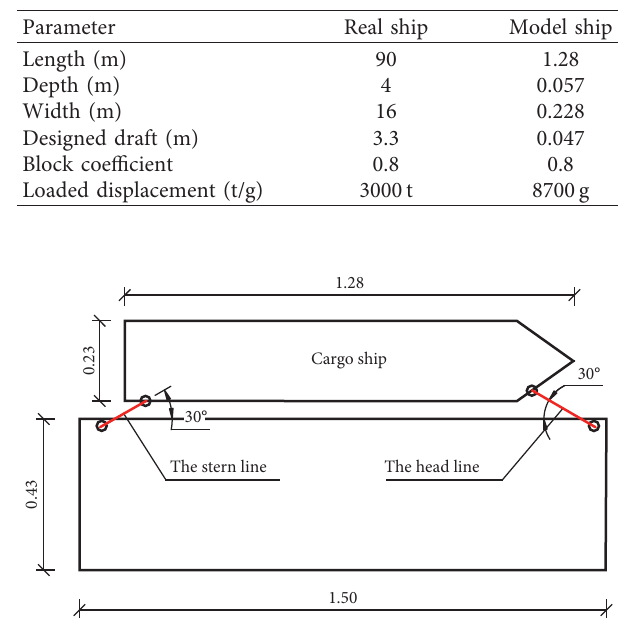
Figure 6: Mooring condition of cargo ship.